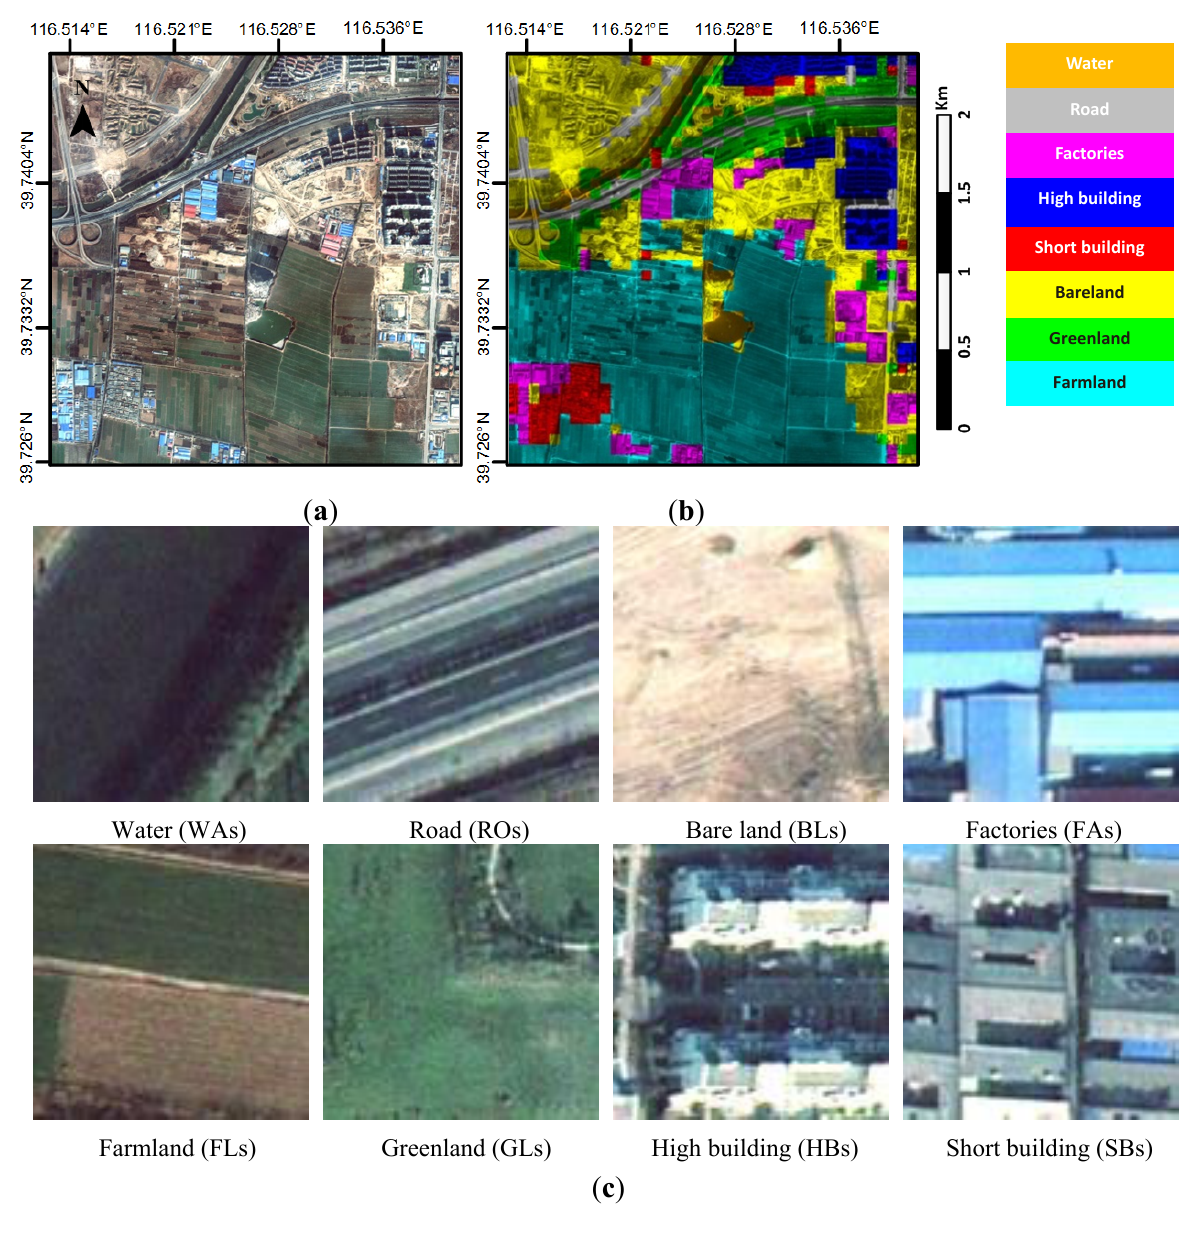
Figure 6. Original image II to be annotated and examples of image II. ( a ) Original image (GeoEye-1). ( b ) Hand-labeled ground truth. ( c ) Example of each class in the eight-class satellite